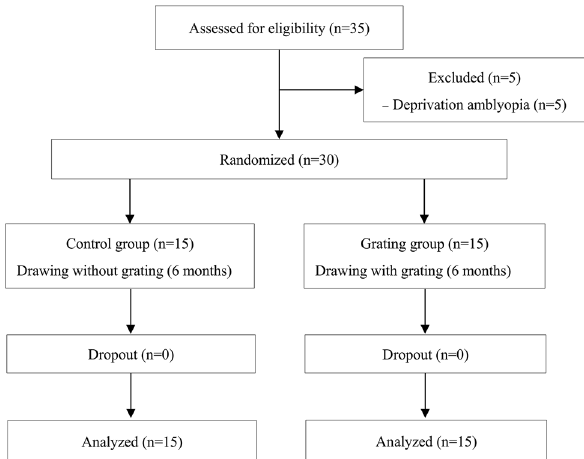
Figure 1. Flow diagram according to the Consolidated Standards of Reporting Trials (CONSORT) statement showing recruitment, randomization, and patient flow in the